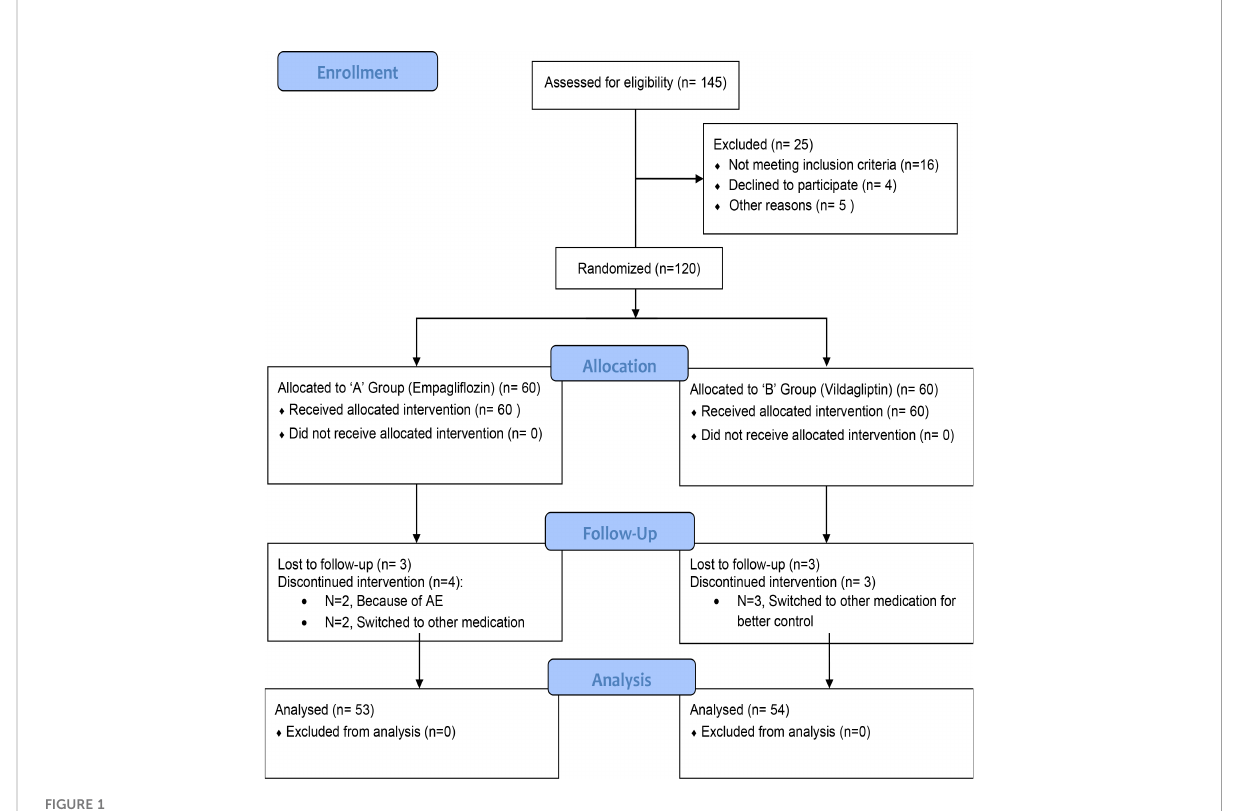
FIGURE 1 Consort fl ow